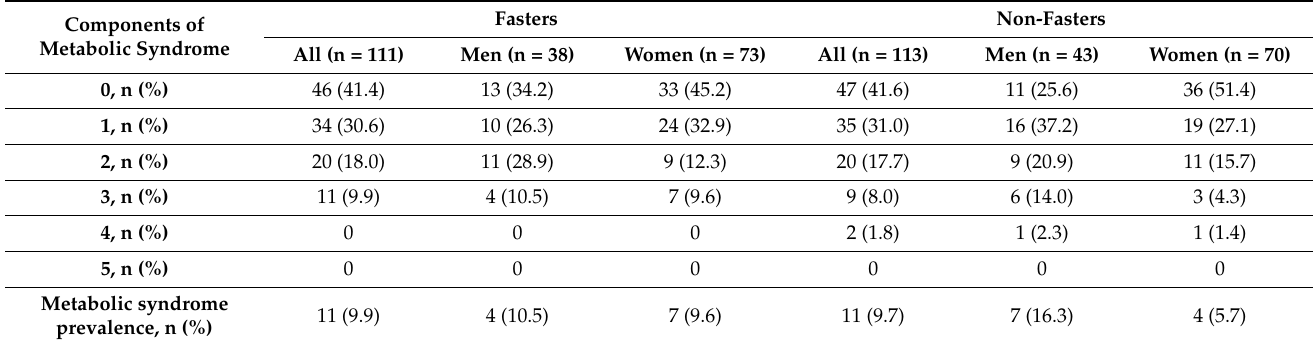
Table 3. Metabolic syndrome components of the